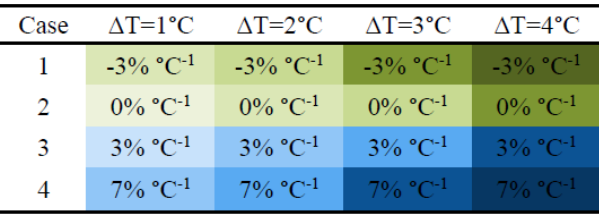
Table 1. The four “temperature increase scenarios” ( (cid:49)T ), and the four scenarios for changes in the mean areal rainfall intensity (ex- pressed by % ◦ C − 1 ). The scenarios apply for both stratiform and convective types, with different peak intensities and spatial statisti- cal properties of rainfall. Colours represent qualitatively changes in the area of the intense rainfall, from a large increase (dark blue) to a large decrease (dark green). For all the scenarios, the peak rainfall intensity is assumed to increase at a rate of 7% ◦ C − 1